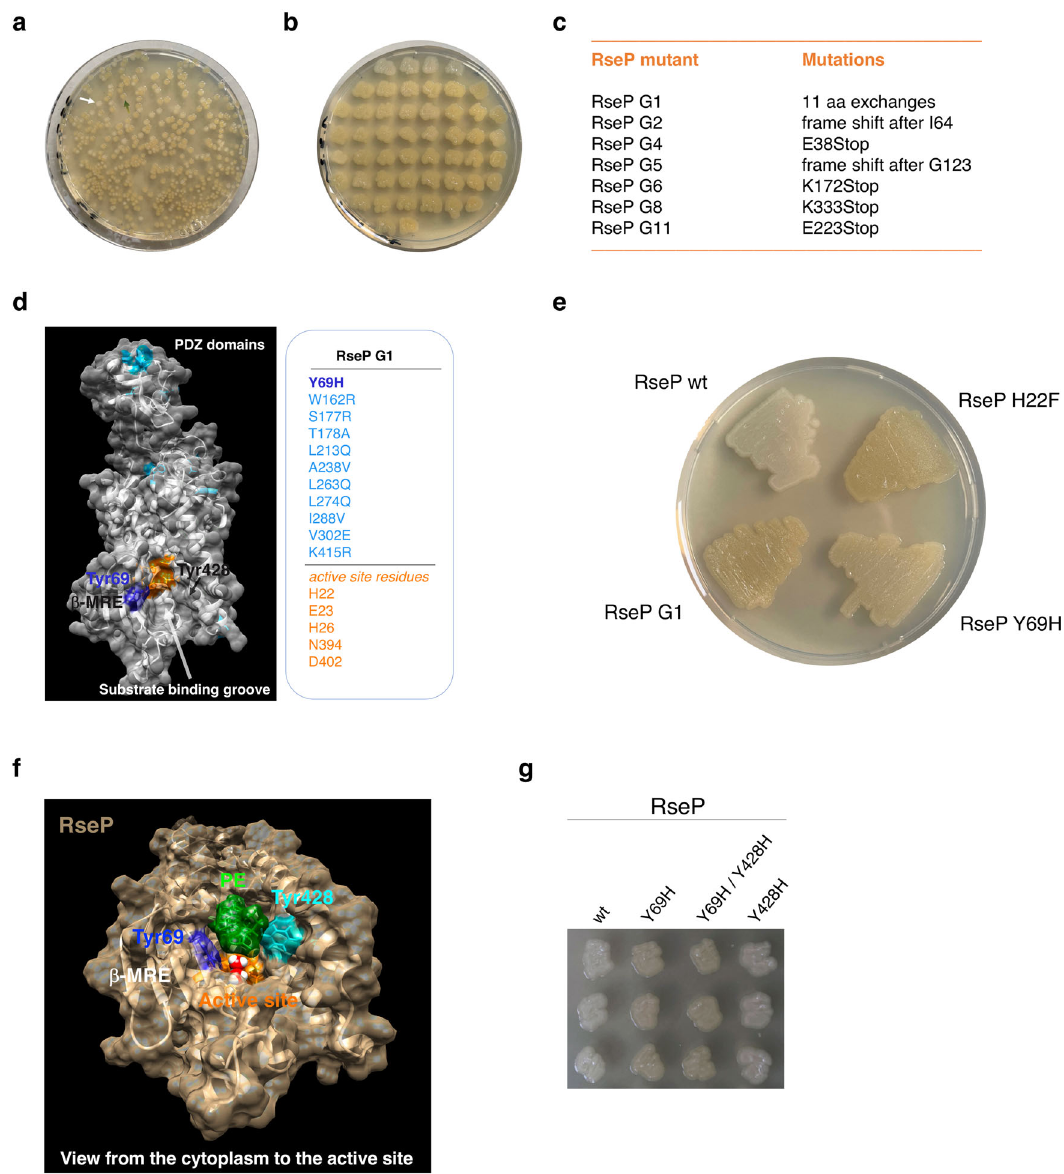
Fig. 6 Error-prone mutagenesis of rseP in combination with the iCliPSpy assay. a Mutant rseP genes were co-transformed with pETDuet-1- MBP mut -TNF α - (1-39)-L31P . The transformation plates were incubated overnight at 37 °C and then at room temperature for two days (as an example, a white colony is indicated by a white arrow and an ocher-green clone by a green arrow). b White (presumably active RseP proteases; fi rst row of the plate) and green clones (inactive RseP) were transferred to a new plate and incubated again for one day at room temperature. c From seven green clones expressing inactive RseP proteases, the plasmids pETDuet-1- MBP mut -TNF α -(1-39)-L31P and pCOLADuet-1- rseP were puri fi ed together and the sequence of mutant rseP genes was determined. d The eleven non-synonymous amino acid substitutions in RseP G1 mutant were mapped to the AlphaFold structure of RseP wt (substituted amino acid residues are shown in light blue). Tyr69 (Y69, dark blue) is the only mutated residue located near the predicted active site (shown in orange); β -MRE, membrane-reentrant β -loop. e The Y69H substitution found in RseP G1 was introduced as a single mutation in RseP and analyzed together with RseP wt, RseP H22F or RseP G1 using the iCliPSpy assay. Cells were incubated at room temperature for four days (overnight incubation at 37 °C followed by incubation at room temperature resulted in less colored RseP Y69H cells). f MD simulations of the AlphaFold RseP wt structure (with Zn 2 + manually curated into the active site) in a membrane environment visualized with Chimera. View from the cytoplasm to the active site [composed of His22, His26 and Asp402 complexing the Zn 2 + ion (shown in black, but mostly hidden by two water molecules) and the residues Glu23 and Asn394] shown in orange. Tyr69 at the cytosol/membrane interface is shown in dark blue, Tyr428 in cyan; β -MRE, membrane-reentrant β -loop. Membrane lipids have been omitted (shown in Supplementary Fig. 5c), except for 1-hexadecanoyl-2-(9Z-hexadecenoyl)- sn -glycero-3-phosphoethanolamine (PYPE, in green), which is adjacent to/inside the binding groove. g Comparison of the in vivo activities of RseP wt, RseP Y69H, RseP Y69H/Y428H and RseP Y428H using the iCliPSpy assay. Cells shown in g had been incubated at room temperature for two days. Error-prone mutagenesis of rseP was performed once, in vivo analysis of RseP Y69H activity ( e ) was performed twice. In vivo assay for RseP wt, RseP Y69H, RseP Y69H/Y428H und RseP Y428H was repeated once with the same result as shown in g